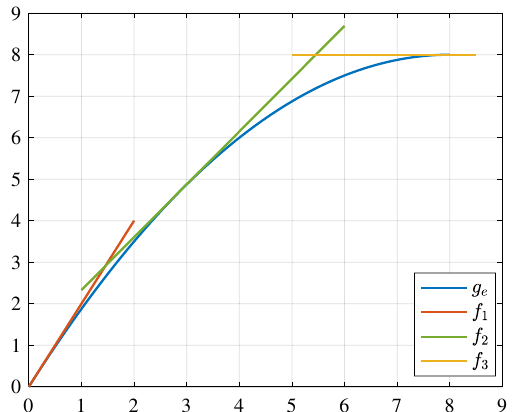
Fig. 2 An example where g e ( x ) = − 0.125 x 2 + 2 x . We want to find a ( 1 + ǫ) -approximation for g e ( x ) everywhere in the range [0, 8] where we set ǫ = 0.1 . The last linear piece f 3 has a zero slope and passes through (8, 8), thus f 3 ( x ) = 8 . The first linear piece f 1 is tangent to g e at the origin, hence f 1 ( x ) = 2 x . At the point x = 1.4545 , f 1 ( x ) = ( 1 + ǫ) g e ( x ) , meaning that f 1 provides a qualified approximation for g e ( x ) in the range [0, 1.4545]. The second linear piece f 2 passes through (1.4545, 2.909) and is tangent to g e at (2.909, 4.7602),namely f 2 ( x ) = 1.2727 x + 1.0579 . At x = 5.2894 , f 2 ( x ) = ( 1 + ǫ) g e ( x ) , hence f 2 provides a qualified approximation for g e ( x ) in the range [1.4545, 5.2894]. The rest of the points in the range [5.2894, 8] have been covered by f